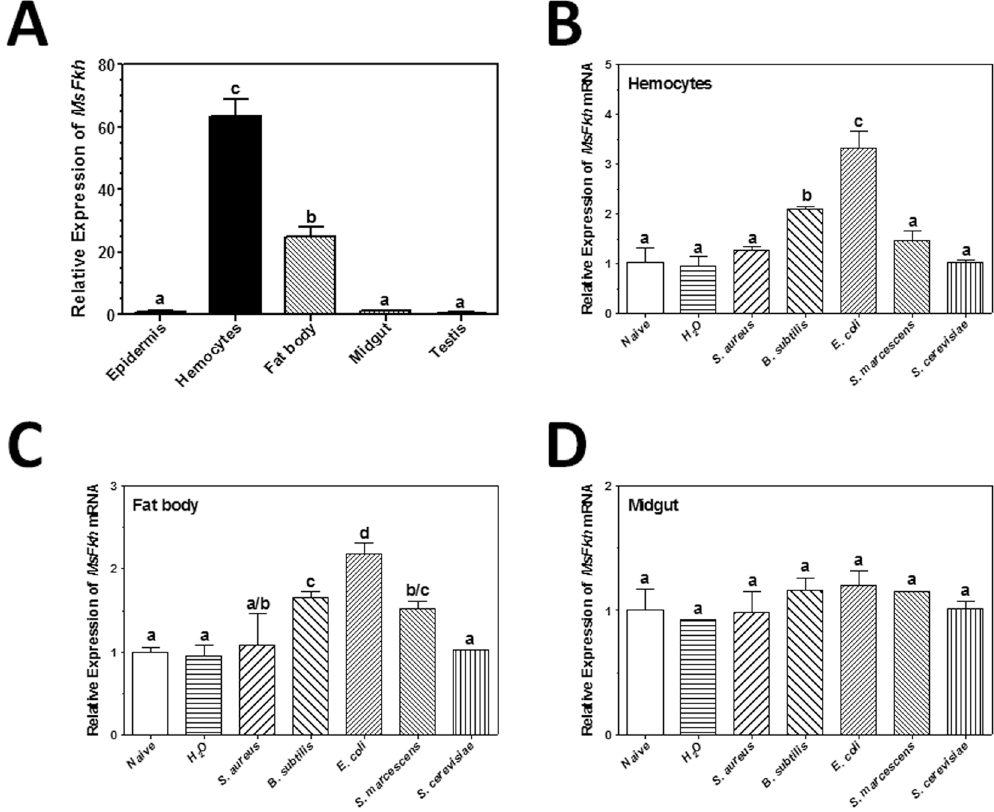
Figure 3. Tissue distribution and induced expression of M. sexta Fkh ( MsFkh ) mRNA. Fat body, hemocytes, midgut, epidermis and testis were collected from M. sexta naïve fifth-instar larvae ( A ). Hemocytes ( B ), fat body ( C ) and midgut ( D ) were also collected from M. sexta larvae at 24 h post-injection of bacteria or yeast for preparation of total RNAs and cDNAs as described in the Materials and Methods. Real-time PCRs were performed with these RNA samples using M. sexta ribosomal protein S3 ( rpS3 ) gene as an internal standard. Expression of MsFkh transcript in the epidermis of naïve larvae ( A ), or in the hemocytes ( B ), fat body ( C ) and midgut ( D ) of naïve larvae was arbitrarily set as 1. Bars represent the mean of three independent measurements ± SEM. Comparing different tissues ( A ) or different injection conditions ( B – D ), identical letters are not significant difference (p > 0.05) while different letters indicate significant difference (p <